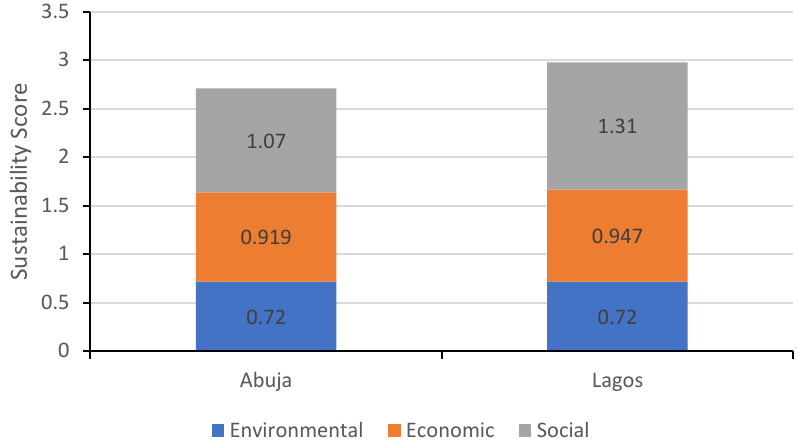
Figure 2. LCSA scores by the MCDA approach for the three sustainability dimensions for WtE in Abuja and Lagos.